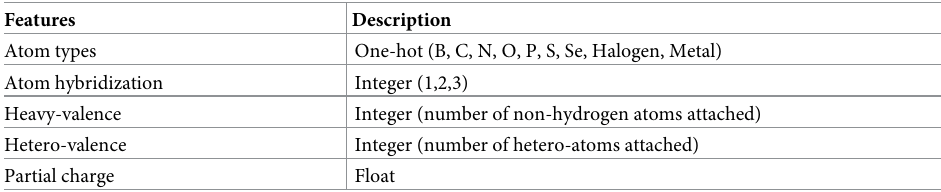
Table 2. Description of the